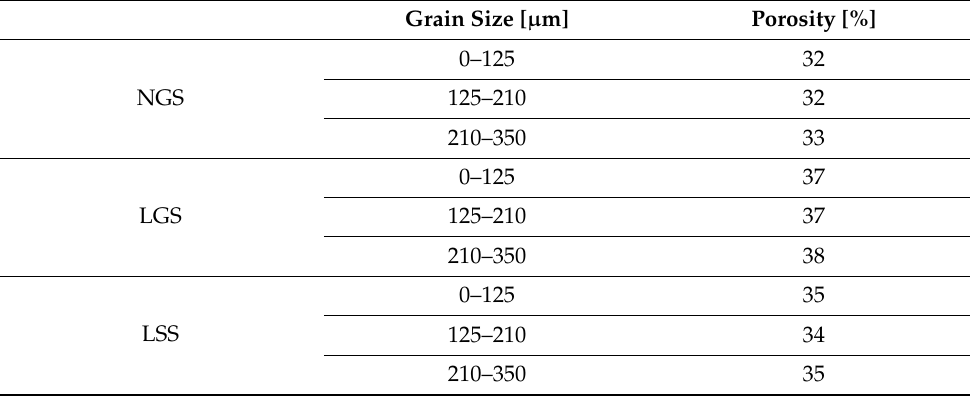
Table 3. Porosity of samples calculated by density measurements.